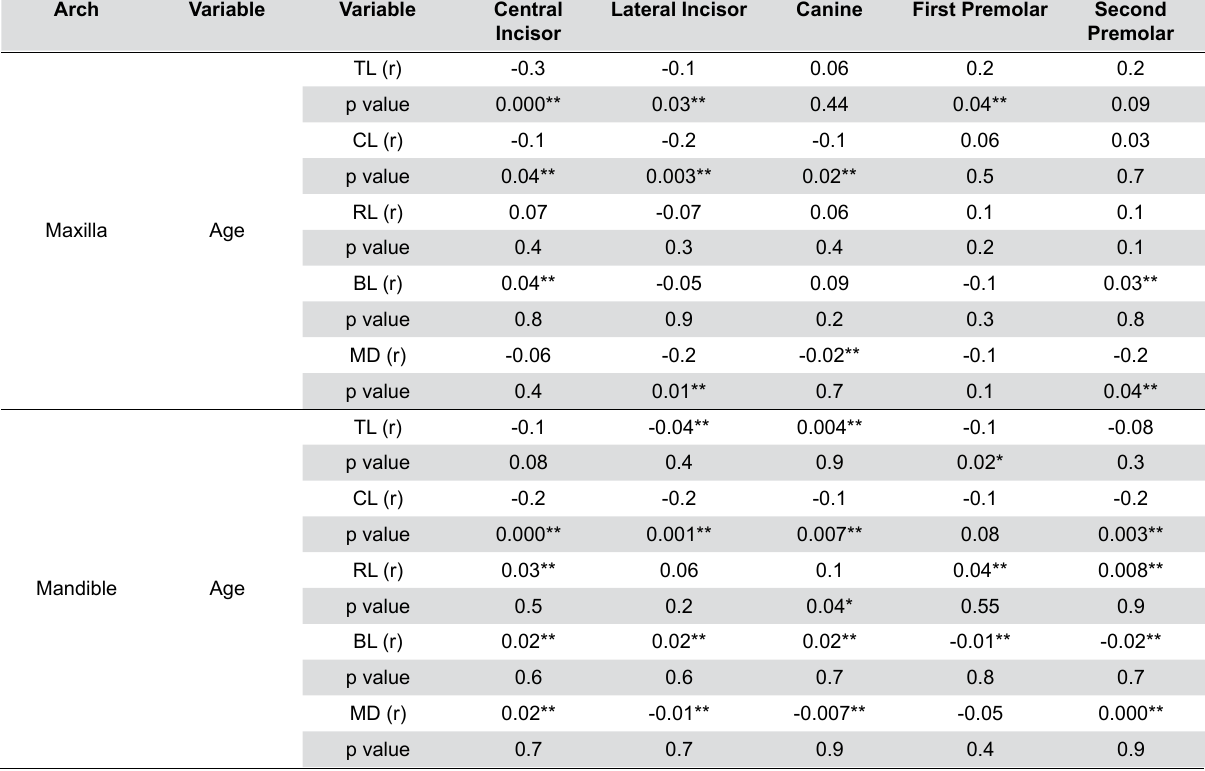
Table 5- Correlations between tooth anatomic lengths and